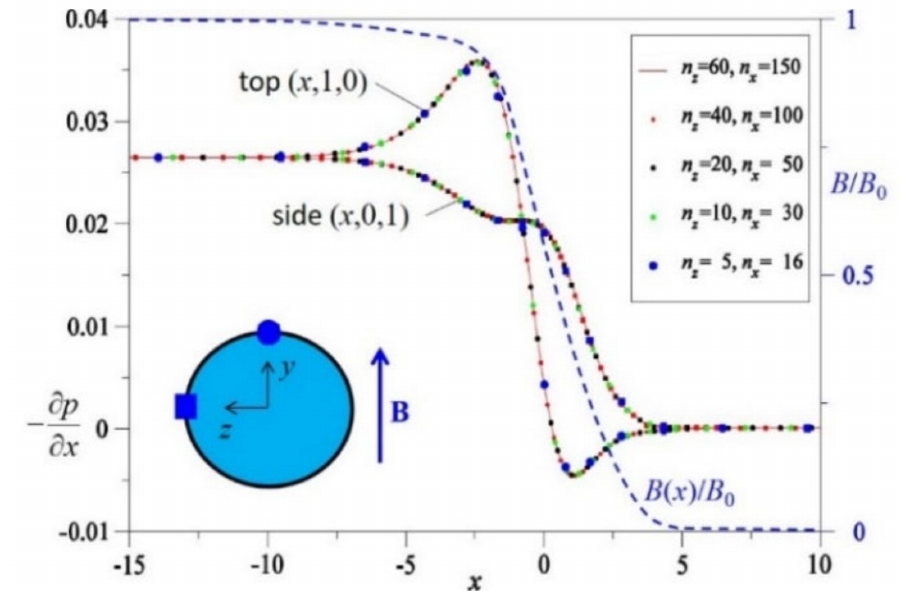
Figure 1. MHD flow in a circular pipe in a fringing magnetic field B ( x ) as used in [12]. In the figure, B ( x ) is normalized by the value B 0 in the center of the magnet. Axial pressure gradients ∂ p / ∂ x are calculated at the top and side of the circular pipe for Ha = 6600. Results displayed for various numerical resolutions n x and n z in x and z directions highlight the rapid convergence of the asymptotic method.